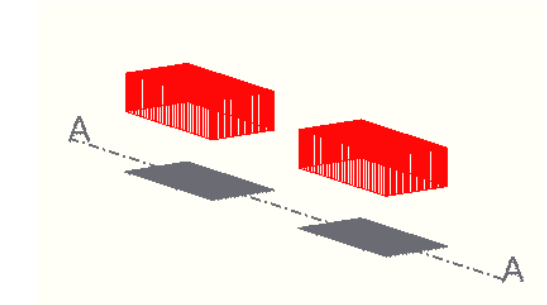
Figure 28: Uniform load distribution over the two rectangular tire- ground contact areas of a twin wheel (the A-A vertical section is taken along the cross-section of the twin wheel).